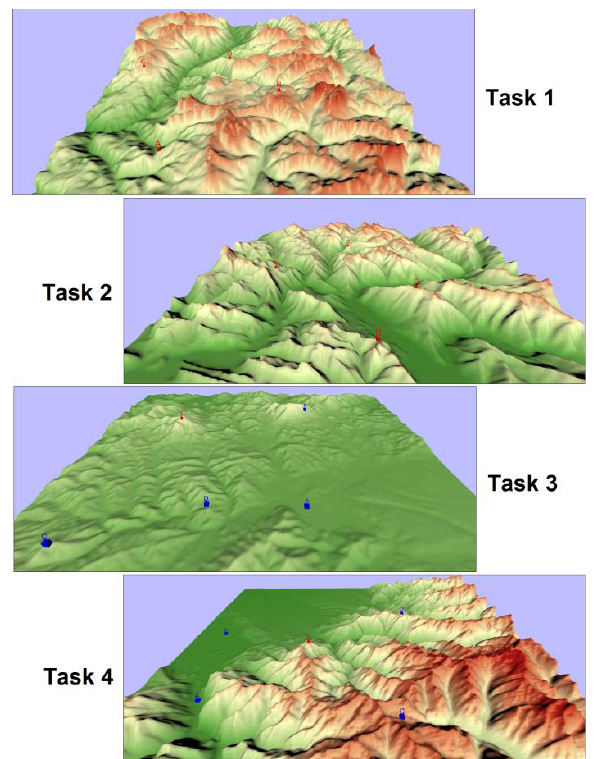
Fig. 4. Starting views similar to perspective views used in static